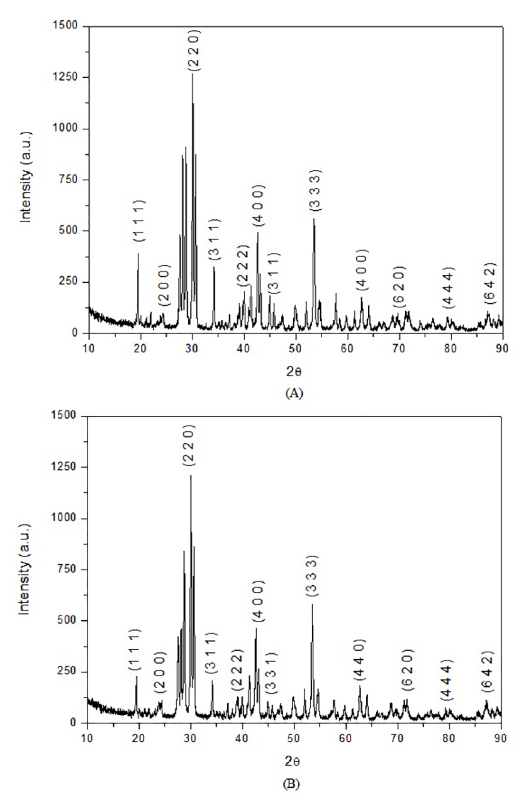
AlNbO ceramics: (A) 2 6